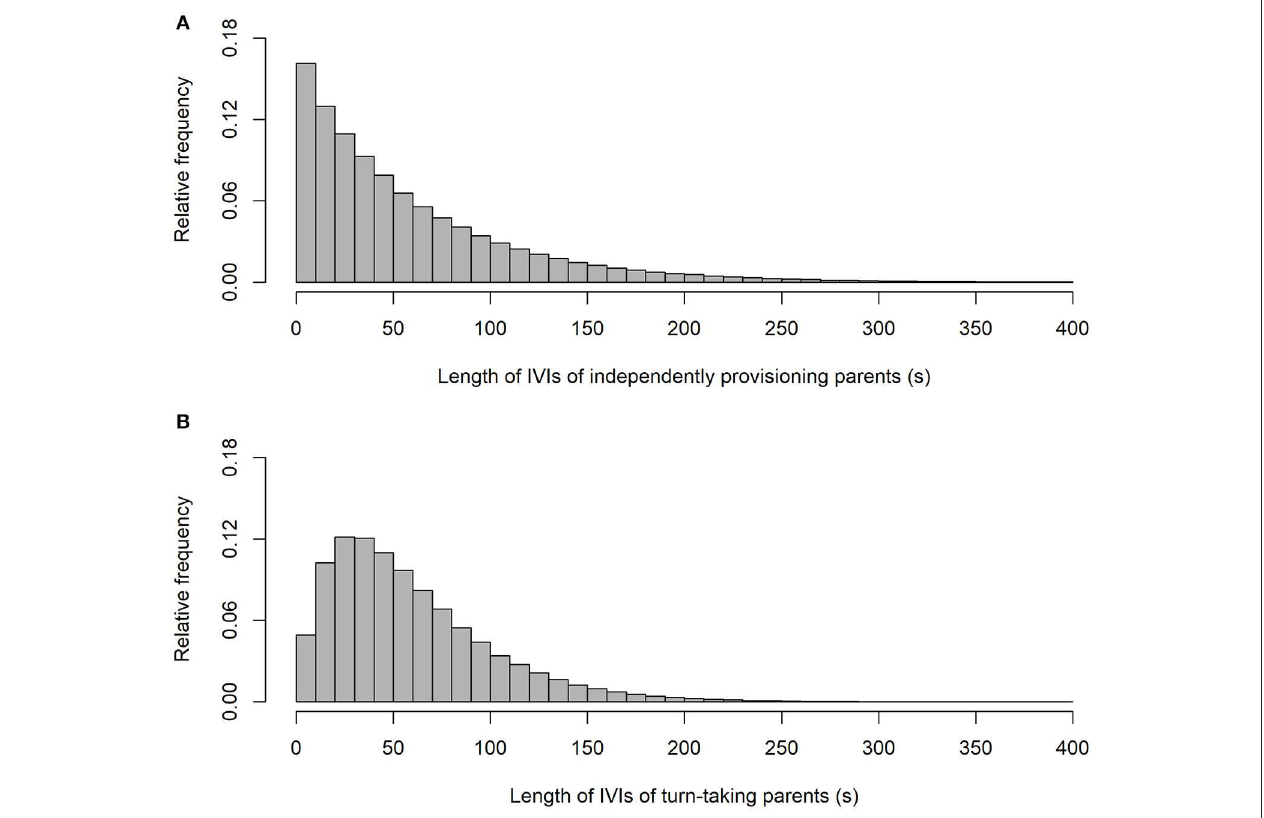
FIGURE 2 | The frequency distributions of inter-visit intervals from simulated provisioning sequences ( n = 1,000) when parents provision independently (A) , and take turns (B)